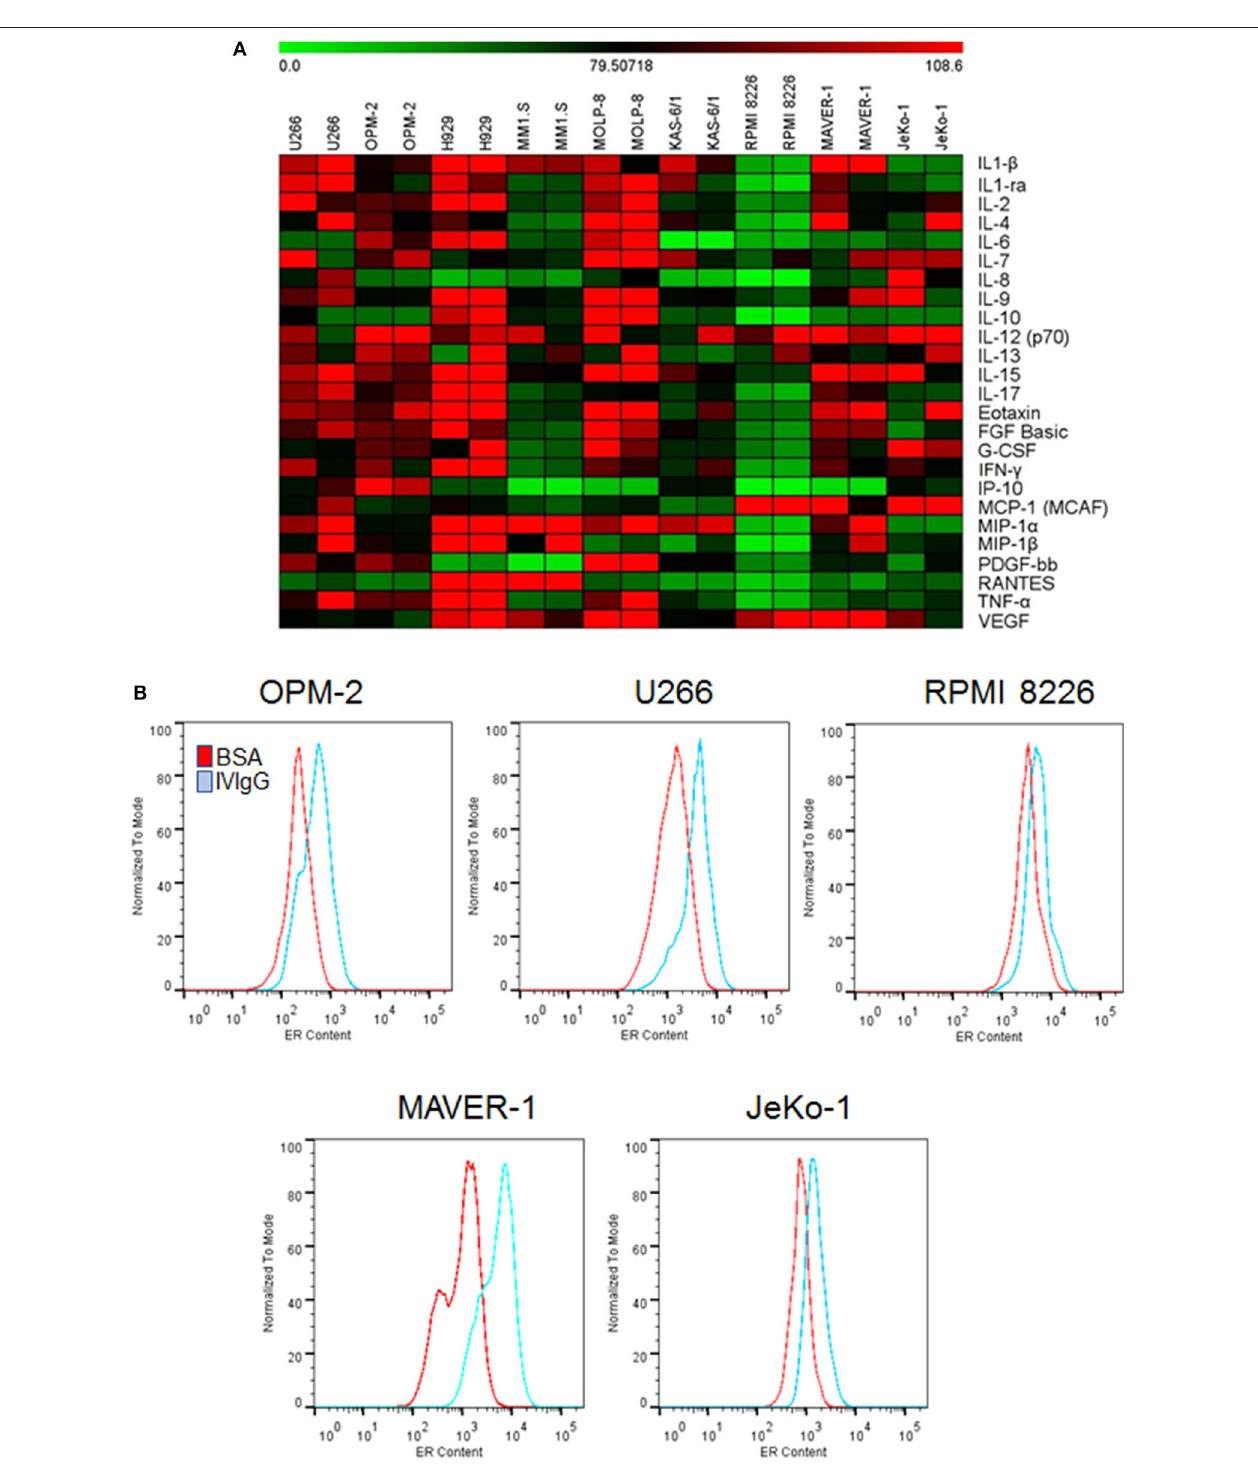
FIGURE 2 | IVIgG-suppresses pro-myeloma and lymphoma cytokines and increases ER abundance. (A) The supernatant from IVIgG- and BSA-treated (10 mg/mL) MM or MCL cells was analyzed using the Bioplex human cytokine array in duplicate. Fold changes in expression were determined using BSA as a normalizing factor for the IVIgG-exposed samples. (B) MM and MCL cells were treated as above for 72h, and live cells stained with ER-Tracker Green and analyzed by flow cytometry.